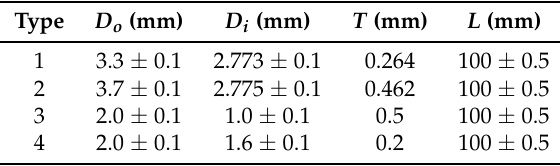
Table 5. Nominal dimensions and tolerances of the